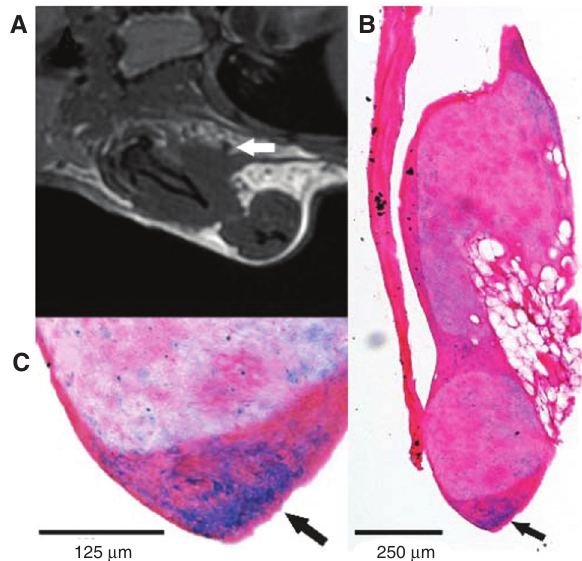
Figure 3 MRI and iron staining of an ipsilateral axillary lymph node 14 days after iron-labeled breast cancer cells were implanted into the thoracic mammary fat pad in CB17 SCID mice. (A) Cropped balanced steady-state free precession image of thorax region of mouse reveals a region of signal loss in the ipsilateral axillary node (arrow). (B) Section of lymph node stained with Perls’ Prussian Blue for iron detection at × 10 magnification shows iron-positive cells in the area of the node corresponding to the signal loss in the MR image (arrow). (C) Iron-positive area of the node at × 40 magnifica- tion, where strong staining can be seen (arrow). (Reproduced with permission from Ref. [47], Copyright Neoplasia Press, Inc, 2013.)